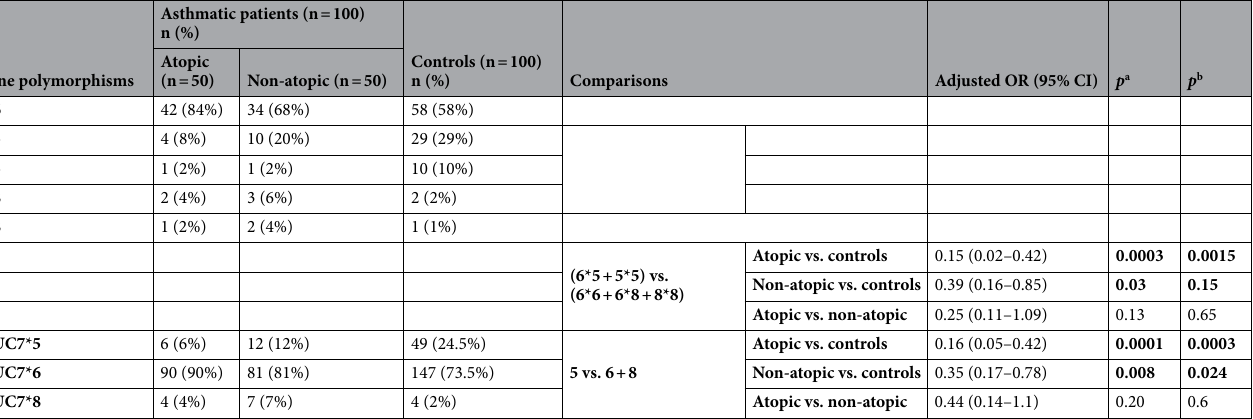
Table 3. Genotypes and allelic frequencies of MUC7 VNTR in atopic and non-atopic asthmatic patients and controls. Data are presented as numbers with percentages. p a : p -value was calculated by Chi square test after adjusting for sex and age. p b : p -value after Bonferroni correction. Bonferroni p -value was calculated as: original p -value * number of comparatives; number of comparatives was 5 for genotypes and 3 for alleles. n number, CI confidence interval, OR odds ratio; p ≤ 0.05 is significant.